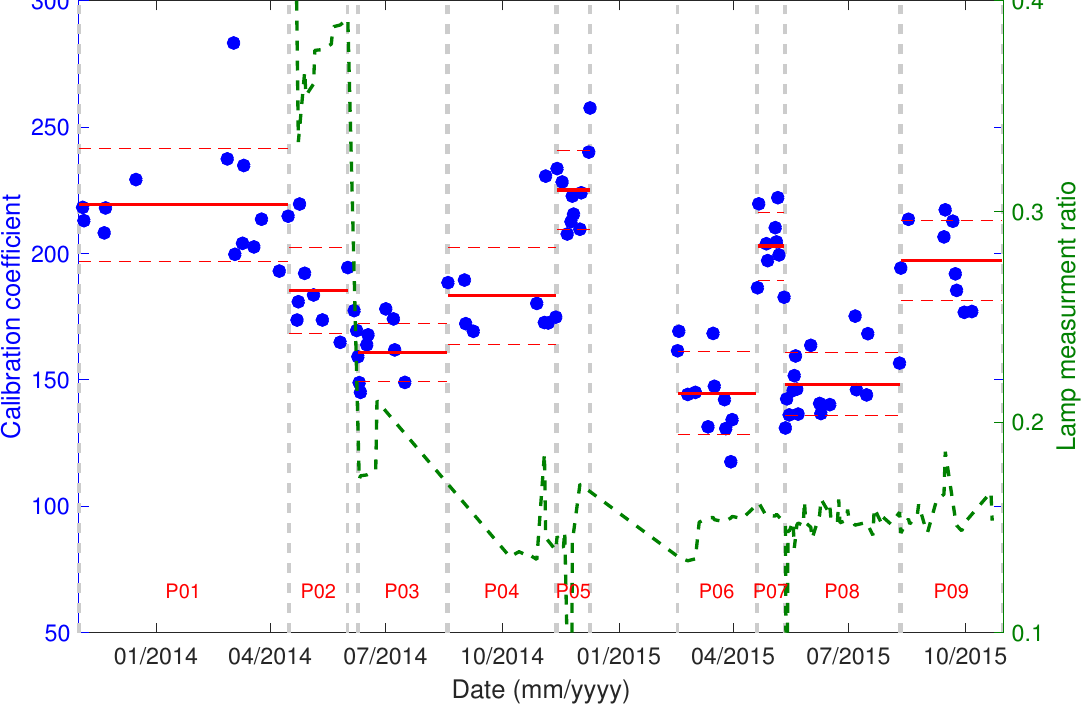
Figure 3. Time series of the nightly coefficients (blue dots) for the Lidar1200 2-year dataset. The vertical dotted lines separate the nine quasi-stationary periods (P01 to P09) of the calibration coefficient. Horizontal solid red segments display values of the average nightly coefficients over the corresponding periods, i.e., the calibration coefficients. The horizontal dotted red segments correspond to values of the mean nightly coefficients plus or minus the standard deviation. The green dotted line corresponds to the lamp measurements made at the beginning of each measurement night from April 2014. The mm/yyyy dates correspond to the first day of the associated month. Table 1. Chart recapitulating the different calibration coefficients of the water vapor data of the Lidar1200 between November 2013 and October